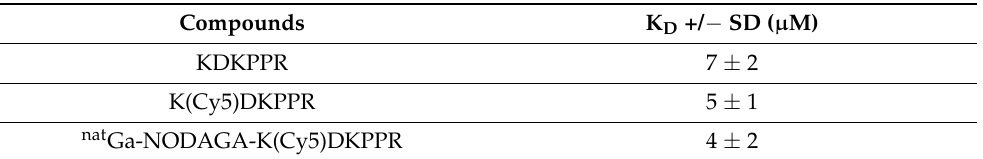
Table 2. Binding to the recombinant NRP-1 protein by SPR. Dissociation constant K D of the complex formed between NRP-1 and the compounds was calculated using the titration curves of the kinetic curve (response (RU) by function of the concentration ( µ M)) using the BiaEvaluation 3.2 software (GE Healthcare, Uppsala,